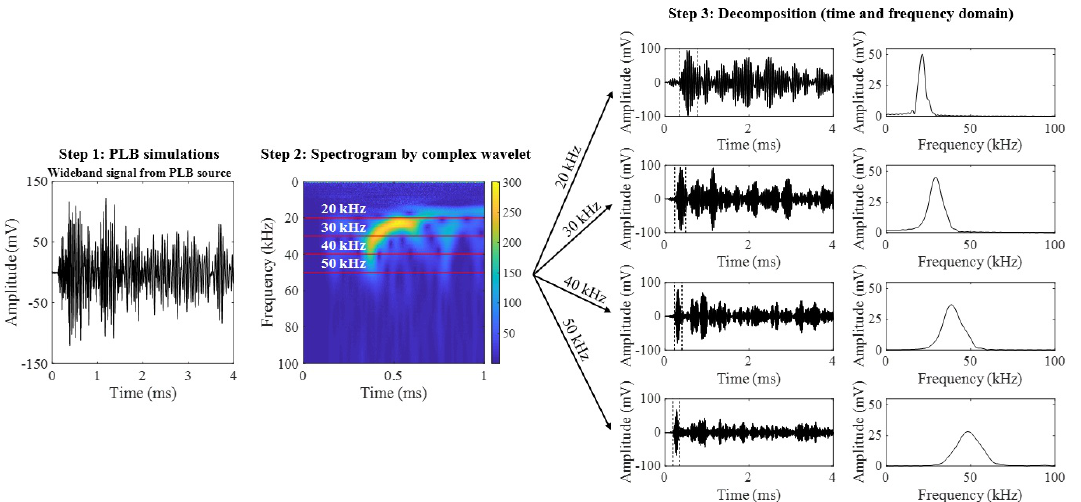
Figure 6. Wavelet decomposition of PLB